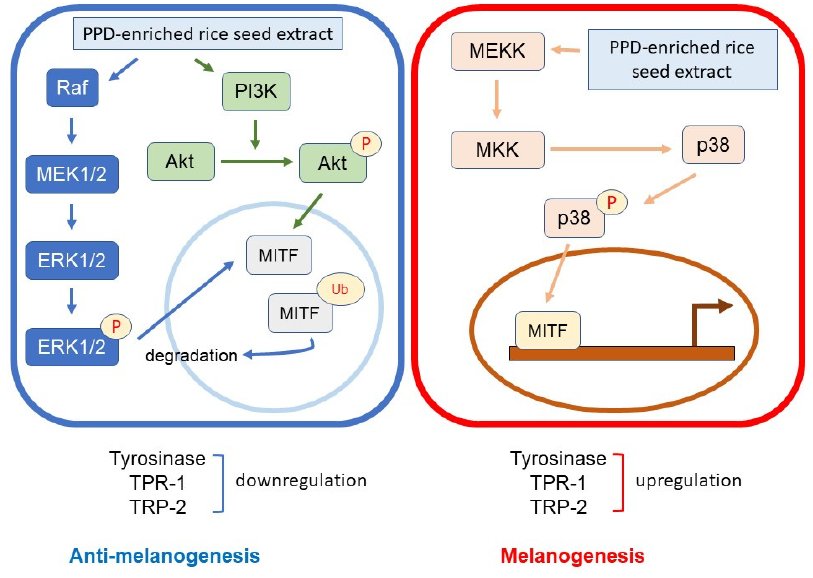
Figure 10. Schematic diagram of the activation of p-ERK 1/2, p-Akt, and p-p38 on melanogenesis regulation.